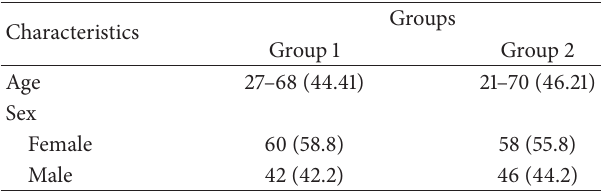
Table 1: Basic characteristics of the patients.